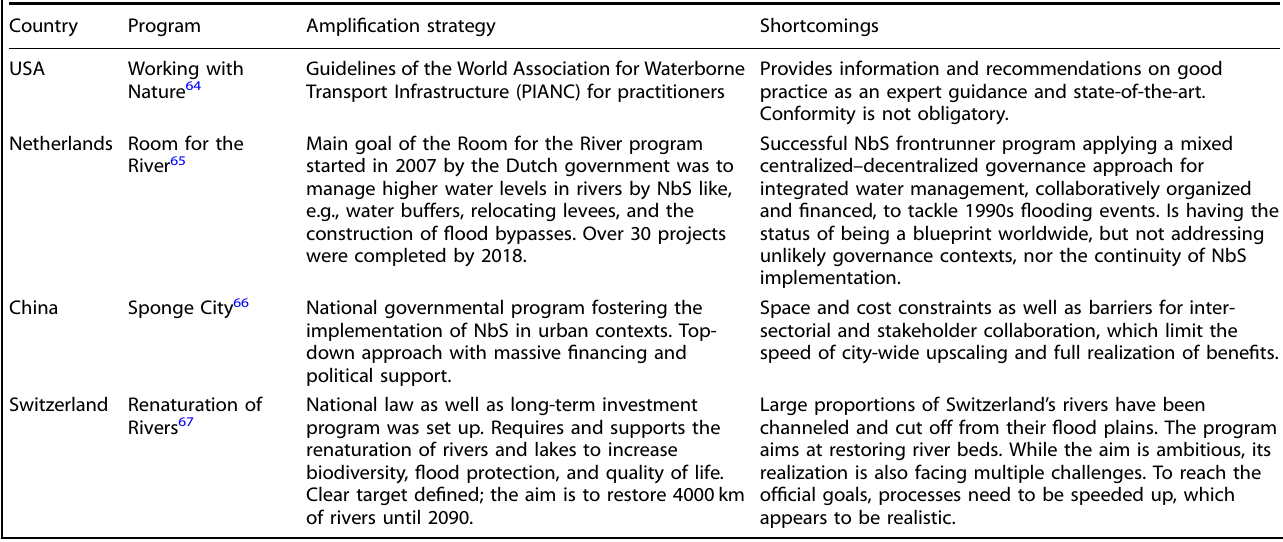
Table 1. International programs for amplifying